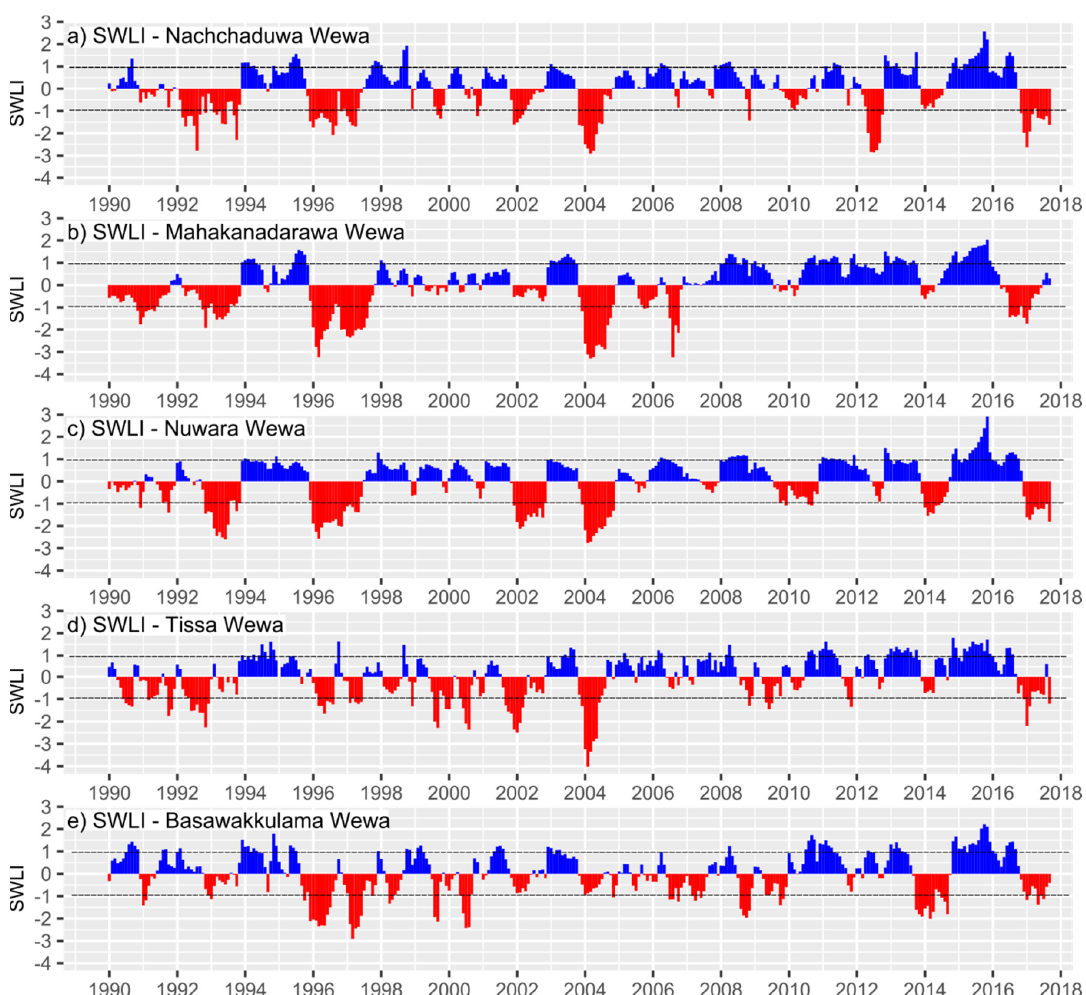
Figure 5. Results of Standardized Water-level Index (SWLI) for the five major tanks ( a ) Nachchaduwa Wewa, ( b ) Mahakanadarawa Wewa, ( c ) Nuwara Wewa, ( d ) Tissa Wewa, ( e ) Basawakkulama Wewa in the headwaters of Aruvi Aru catchment. Blue bars mark SWLI values > 0, red bars mark SWLI values < 0. SWLI values between 0.99 and − 0.99 (area between the dashed lines) are classified as near normal conditions.